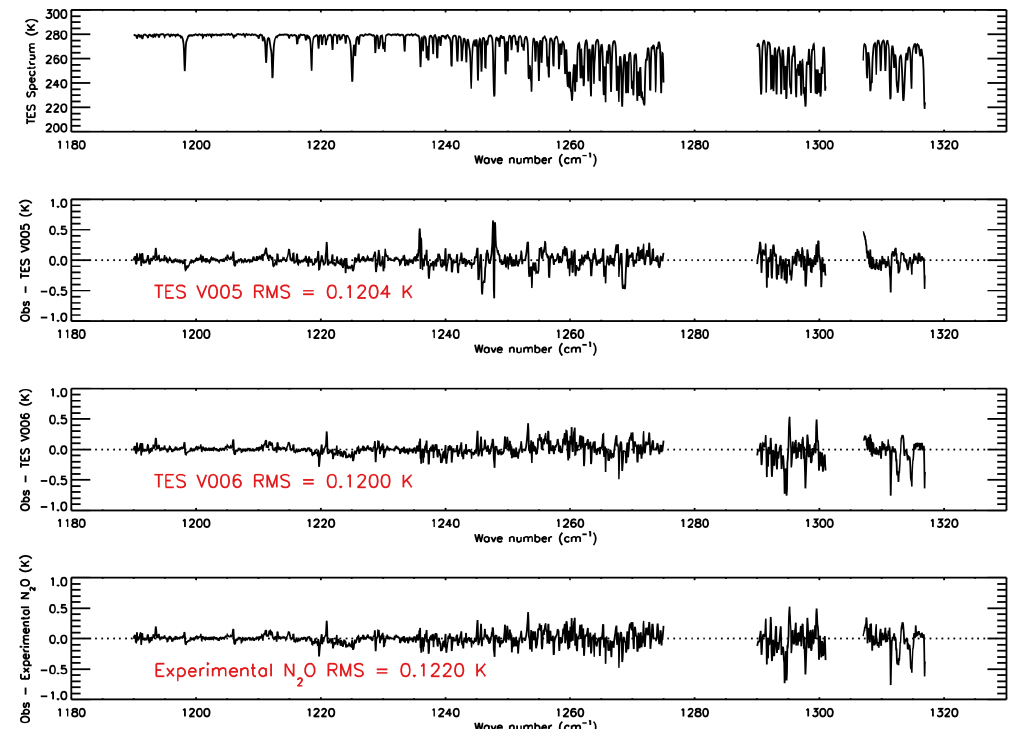
Figure 2. Mean spectral residuals after retrieval in the areas used to simultaneously retrieve CH 4 , N 2 O, HDO, and H 2 O from TES radiances. (a) Example TES spectrum. (b) Mean TES residuals after TES Version 5 retrievals for the 518 TES scans analyzed in this study (see Table 2). (c) Mean TES residuals after TES Version 6 retrievals. (d) Mean TES residuals after retrievals as in TES Version 6, but with the proposed updated N 2 O spectroscopy from HITRAN